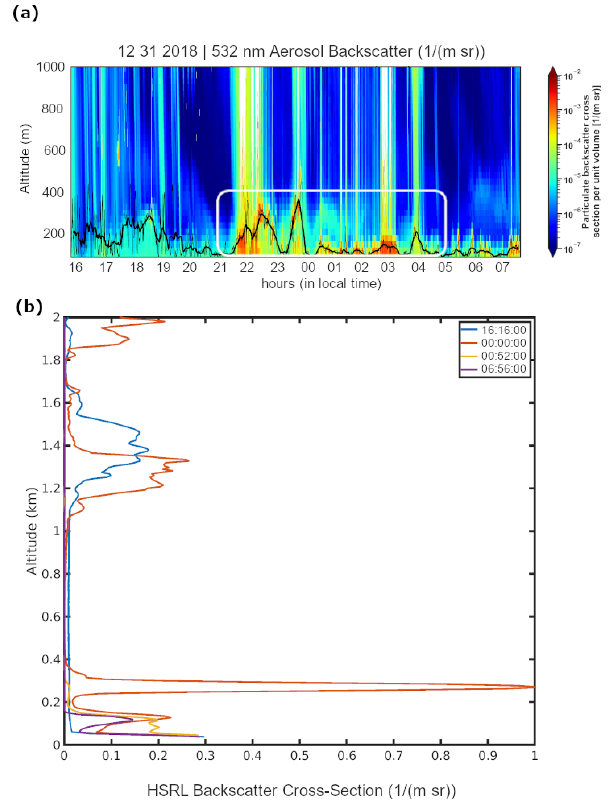
Figure 3. (a) Time series of the aerosol backscatter vertical profile from the high-spectral-resolution lidar (HSRL). The time shown is local time (UTC + 8) at the Manila Observatory. The times circled by the white oval correspond to the peak of aerosol backscatter in the mixing layer due to firework activity. The approximate surface- attached aerosol layer height is shown as a thick black line. It is derived from a 30min moving window average based on the 1min values shown as a thin black line. (b) Vertical profiles of aerosol backscatter at specific UTC times of interest before, during, and after the